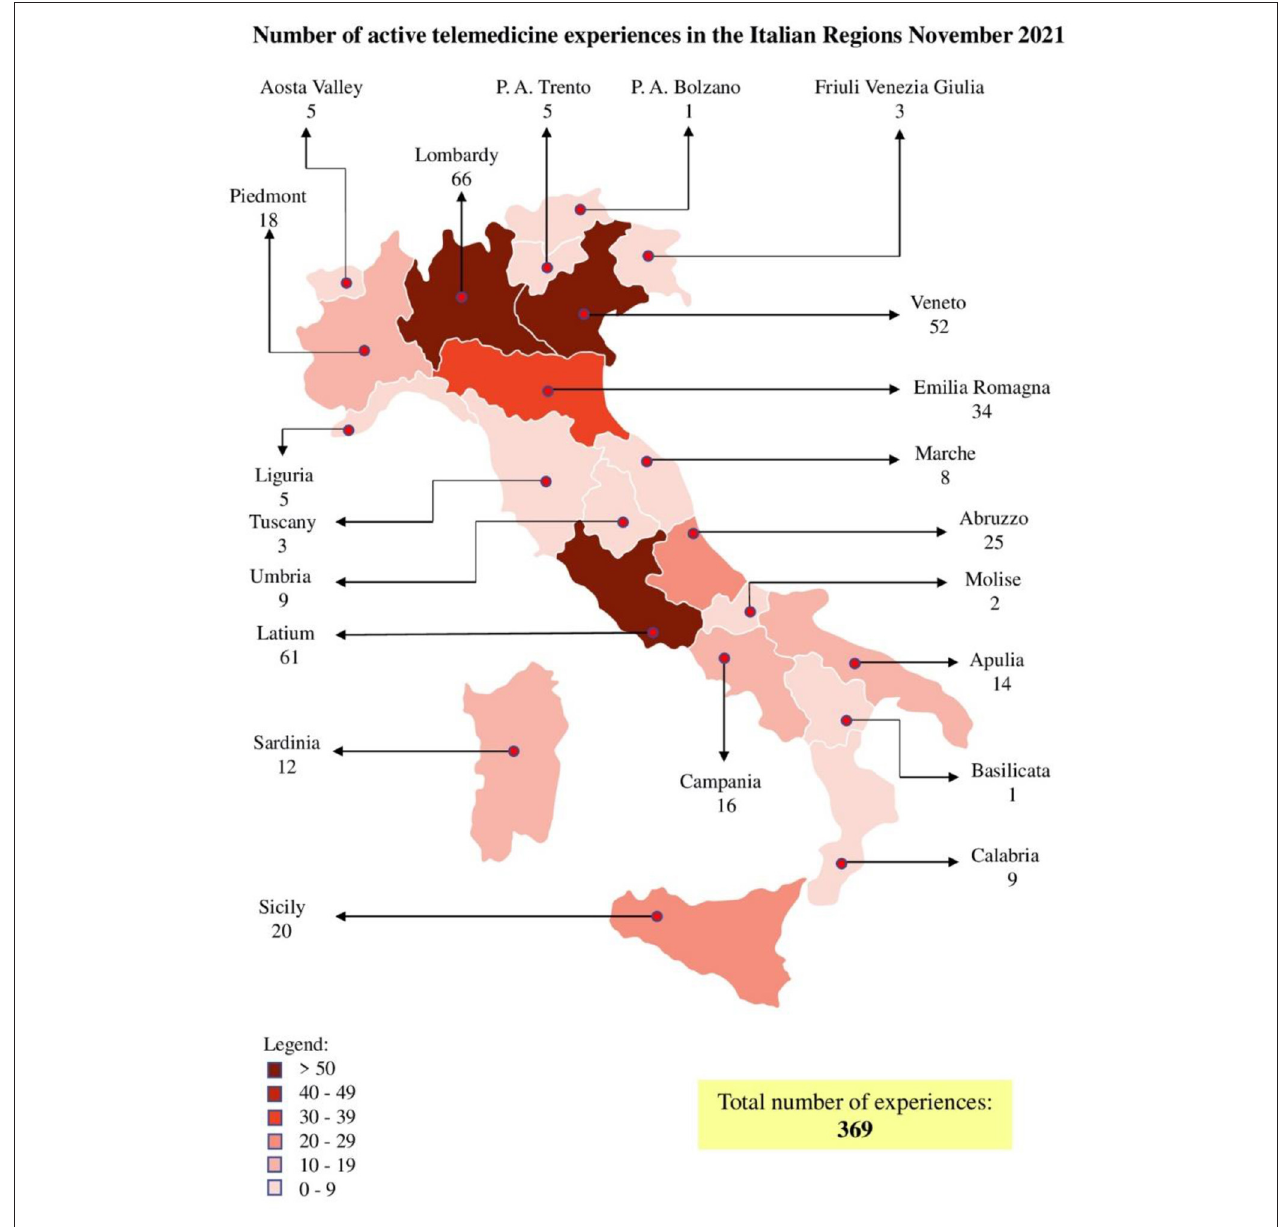
FIGURE 3 | Distribution of active Telemedicine experiences in